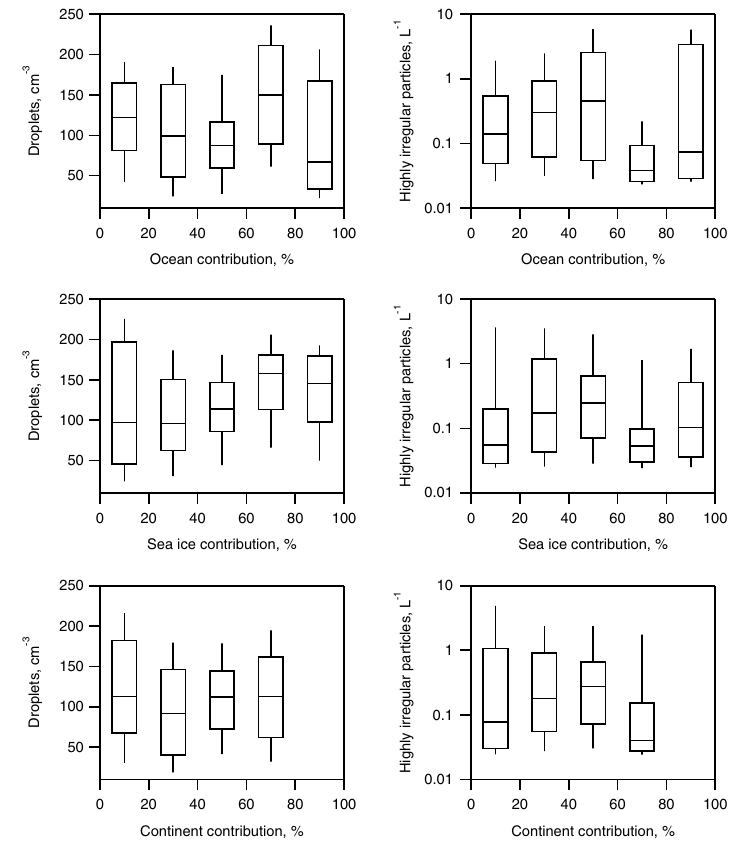
Figure 13. The concentration of cloud droplets and 2DS highly irregular particles as a function of the air mass contribution from the Southern Ocean, sea ice and the continent (see text for details). Boxes give the 25th and 75th and the whiskers mark the 10th and 90th percentiles for each regional contribution bin.